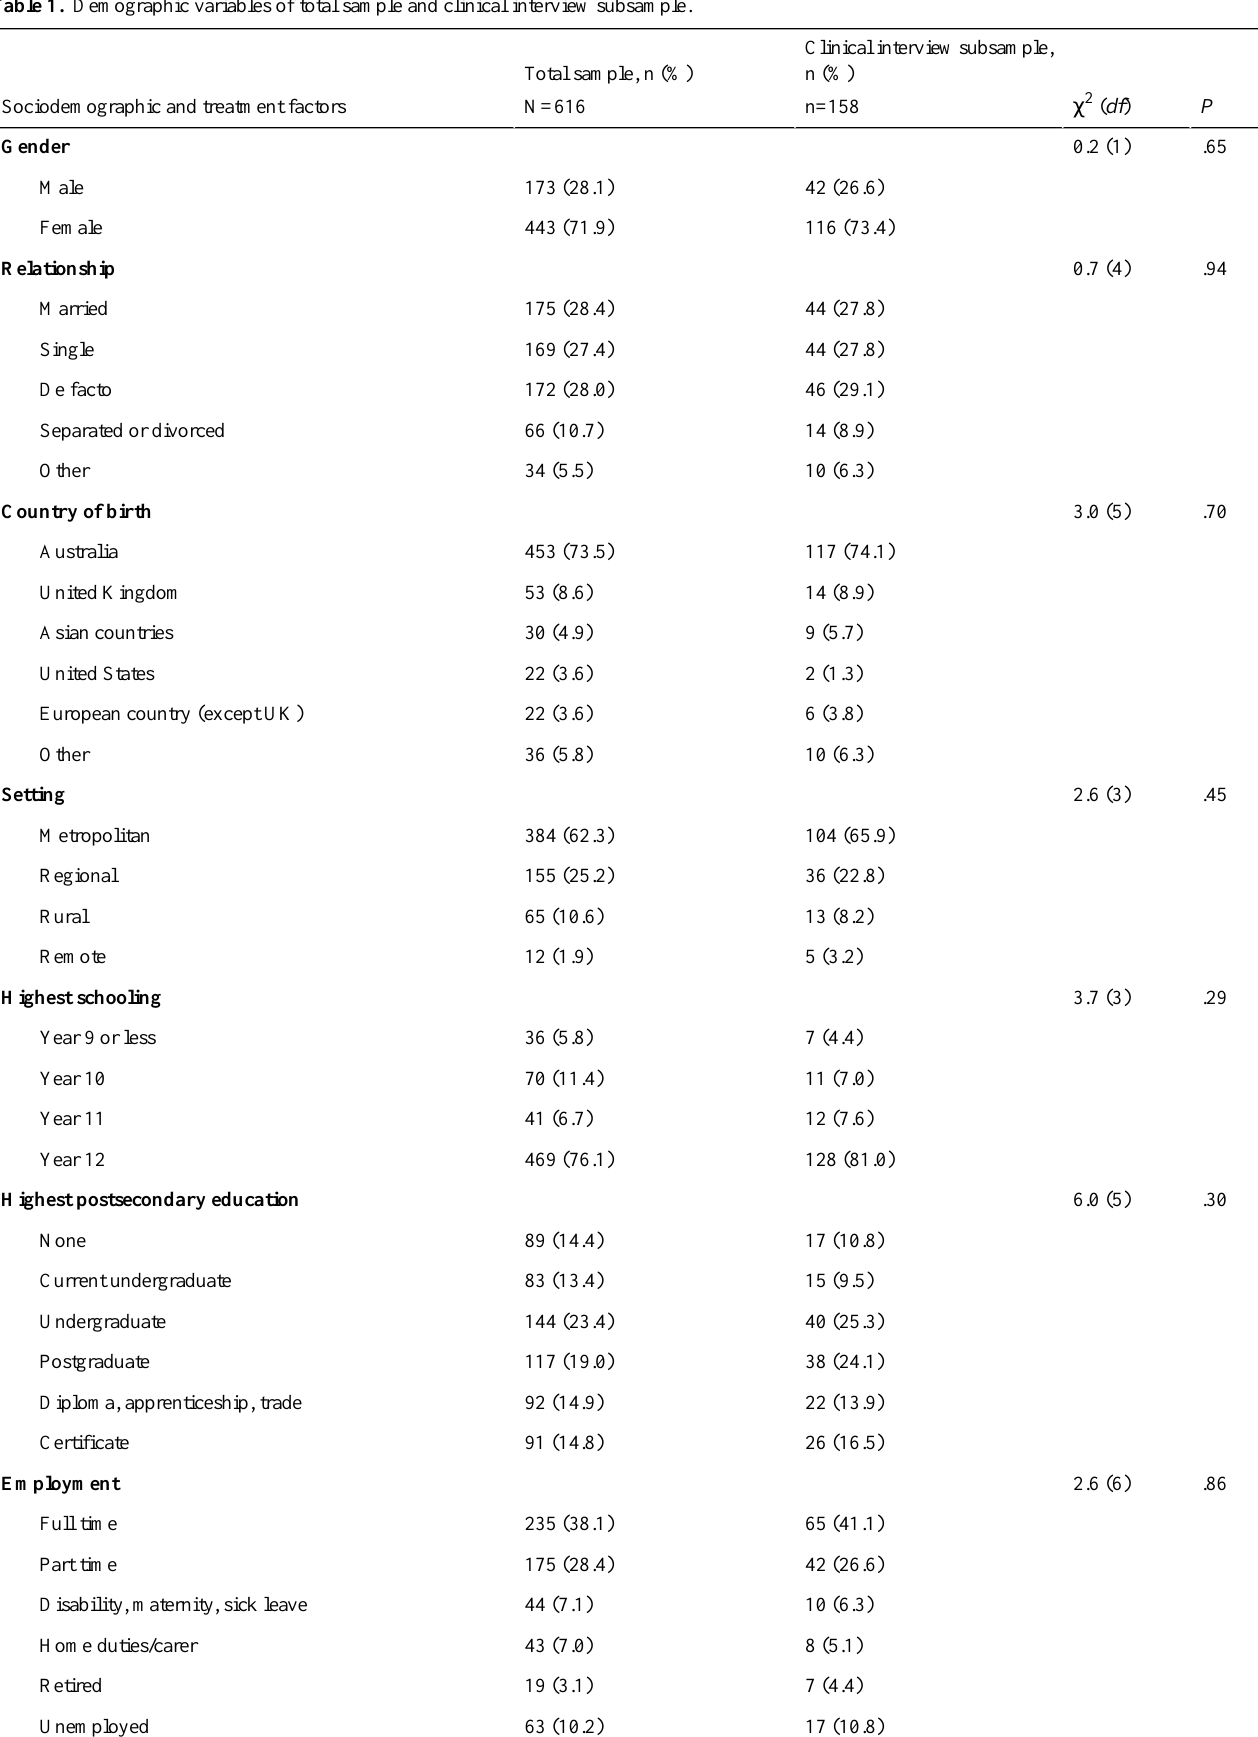
Table 1. Demographic variables of total sample and clinical interview